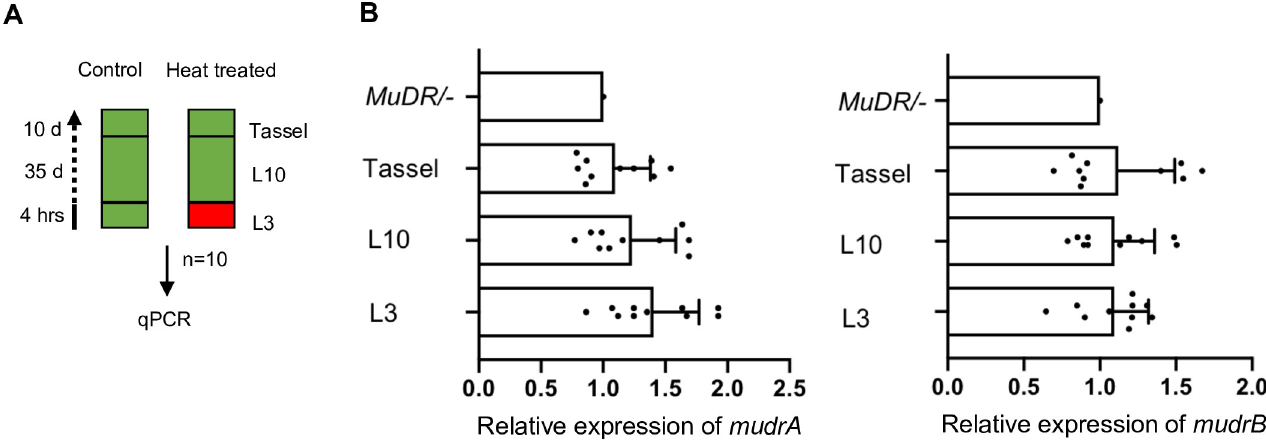
Fig 5. Expression of mudrA and mudrB in new emerging tissues following heat stress. (A) Diagram of the experiment. (B) qPCR was performed to measure transcript levels of mudrA and mudrB using expression of Tub2 as an internal control. Expression levels were normalized to that of an active MuDR element. Error bars indicate mean ± standard deviation (SD) of the ten biological